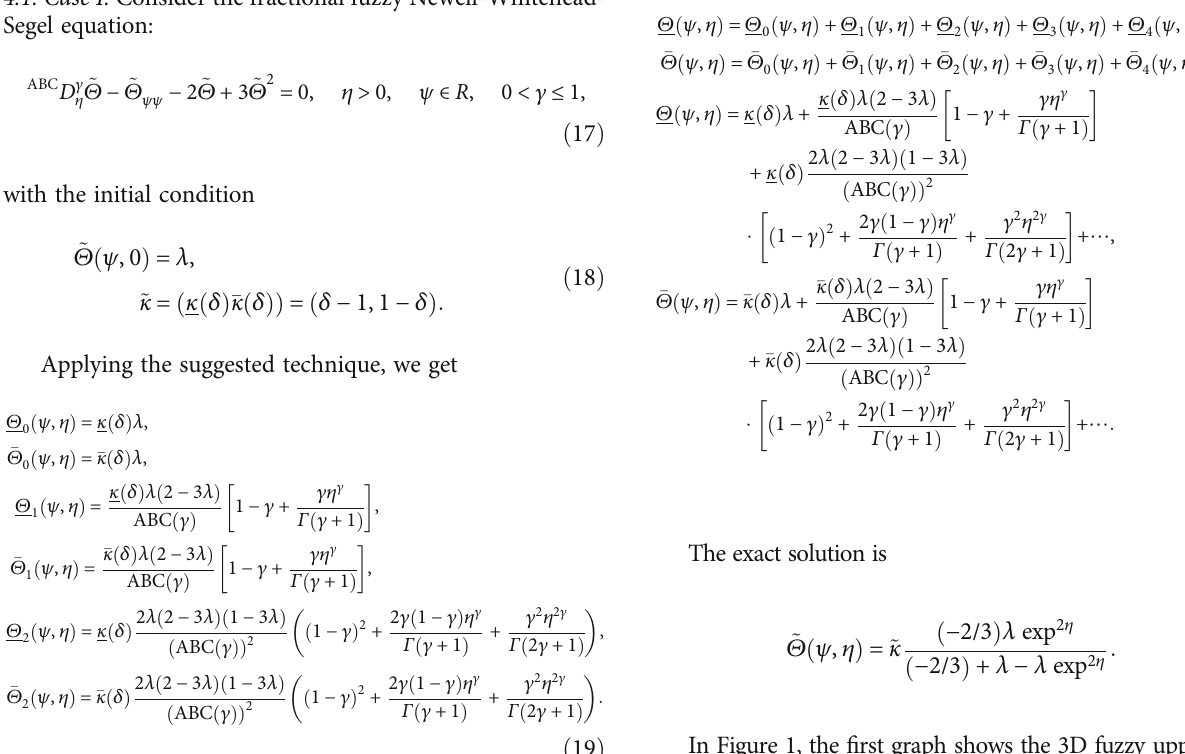
In Figure 1, the fi rst graph shows the 3D fuzzy upper and lower fi gure of an analytical solution at γ = 1 and second the fractional graph of γ = 0 : 8 . Figure 2 shows the 3D fuzzy fi gure of upper and lower of an analytical solution at γ = 0 : 6 and the second fi gure at fractional order of γ = 0 : 4 . In Figure 3, the fi g- ure shows the 3D fuzzy fi gure of upper and lower of various fractional orders of γ . Figure 4 shows the 2D fuzzy fi gure of the upper and lower of various fractional orders of γ .